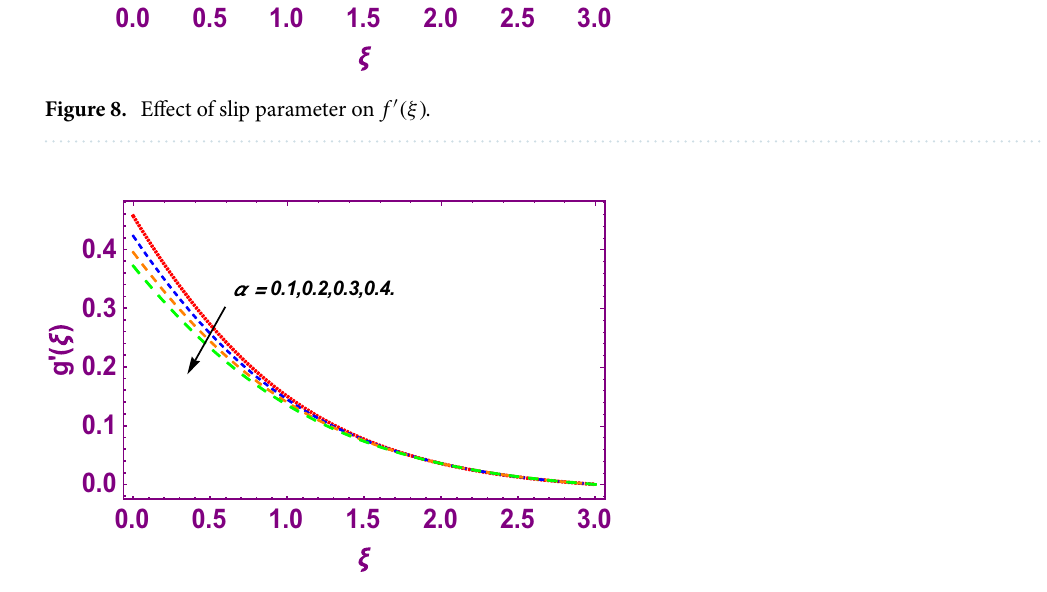
Figure 9. Effect of slip parameter on g ′ (ξ)